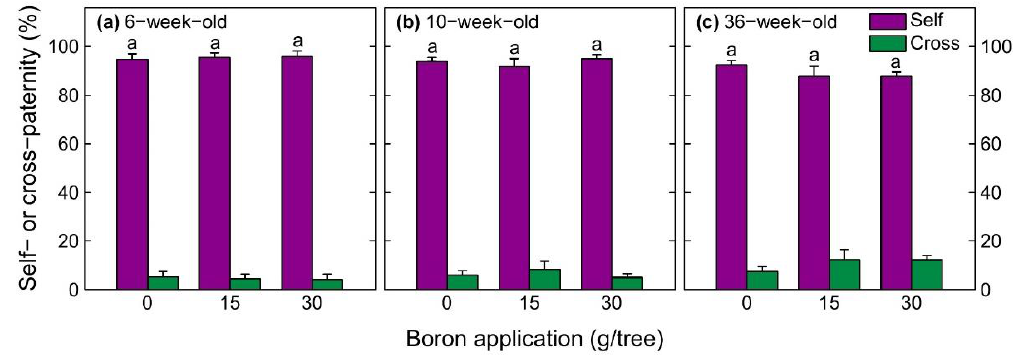
Figure 5. Percentages of self-pollinated and cross-pollinated ( a ) 6-week-old fruitlets, ( b ) 10-week-old fruitlets, and ( c ) 36-week-old fruit (i.e., mature fruit) in the canopies of Hass avocado trees treated with 0, 15 or 30 g boron (B) per tree prior to anthesis. Means (+SE) within a time point do not differ significantly (generalised linear models, p > 0.05, n = 10 trees).